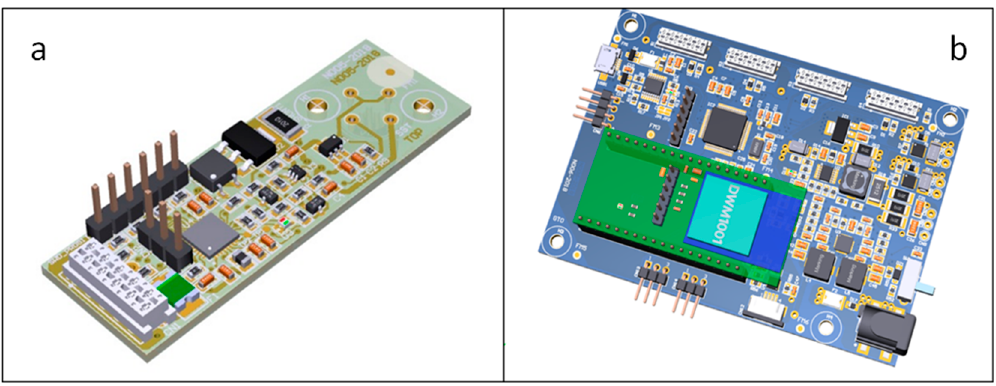
Figure 2. Sensor control board ( a ) and motherboard ( b ).